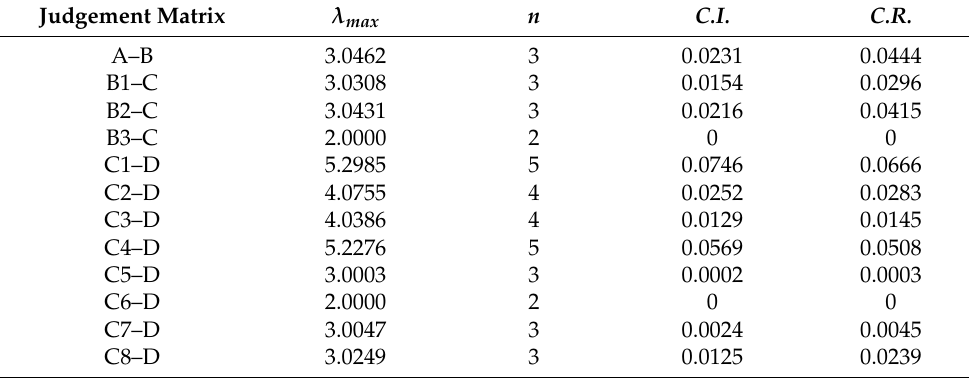
Table 7. The consistency test results for the judgment